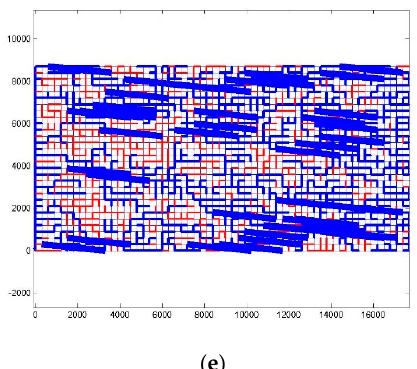
Figure 11. The influence of the fracture direction on absolute permeability and displacement efficiency in Type II (The red throats and fractures are filled with oil and the blue throats and fractures are filled with water). ( a ) No fracture; ( b ) Parallel to the flow direction; ( c ) Perpendicular to the flow direction; ( d ) Multi-direction; ( e ) 30° of the flow direction.